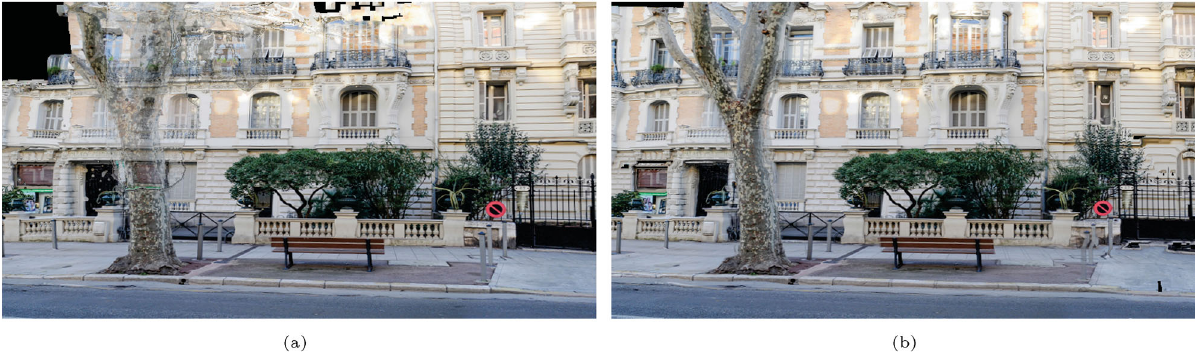
Fig. 11 Comparison of images interpolated by our approach (a) without the homography check, (b) with the homography